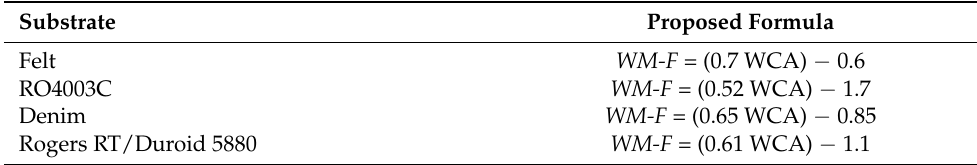
Table 2. Proposed Formulae for Different Substrate